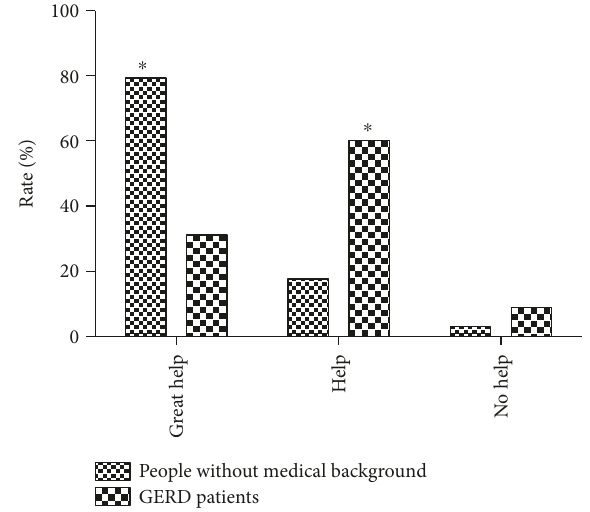
Figure 5: Evaluation of pictograms on the understanding of classic re fl ux symptoms. ∗ P < 0 05 compared with the GERD patients, Fisher ’ s exact test.